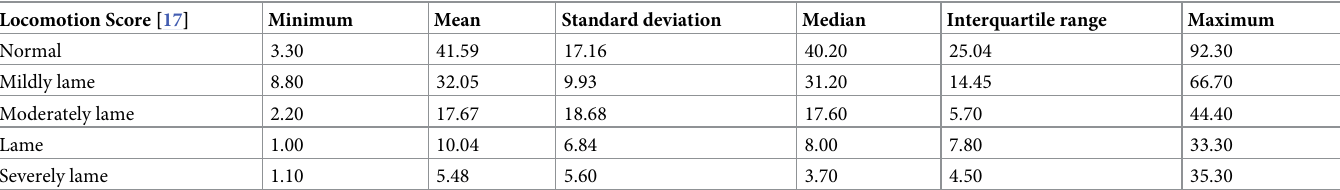
Table 3. Farm-level prevalence of locomotion scores across the 166 farms (7,320 cows) in the final, complete cases data set for analysis.